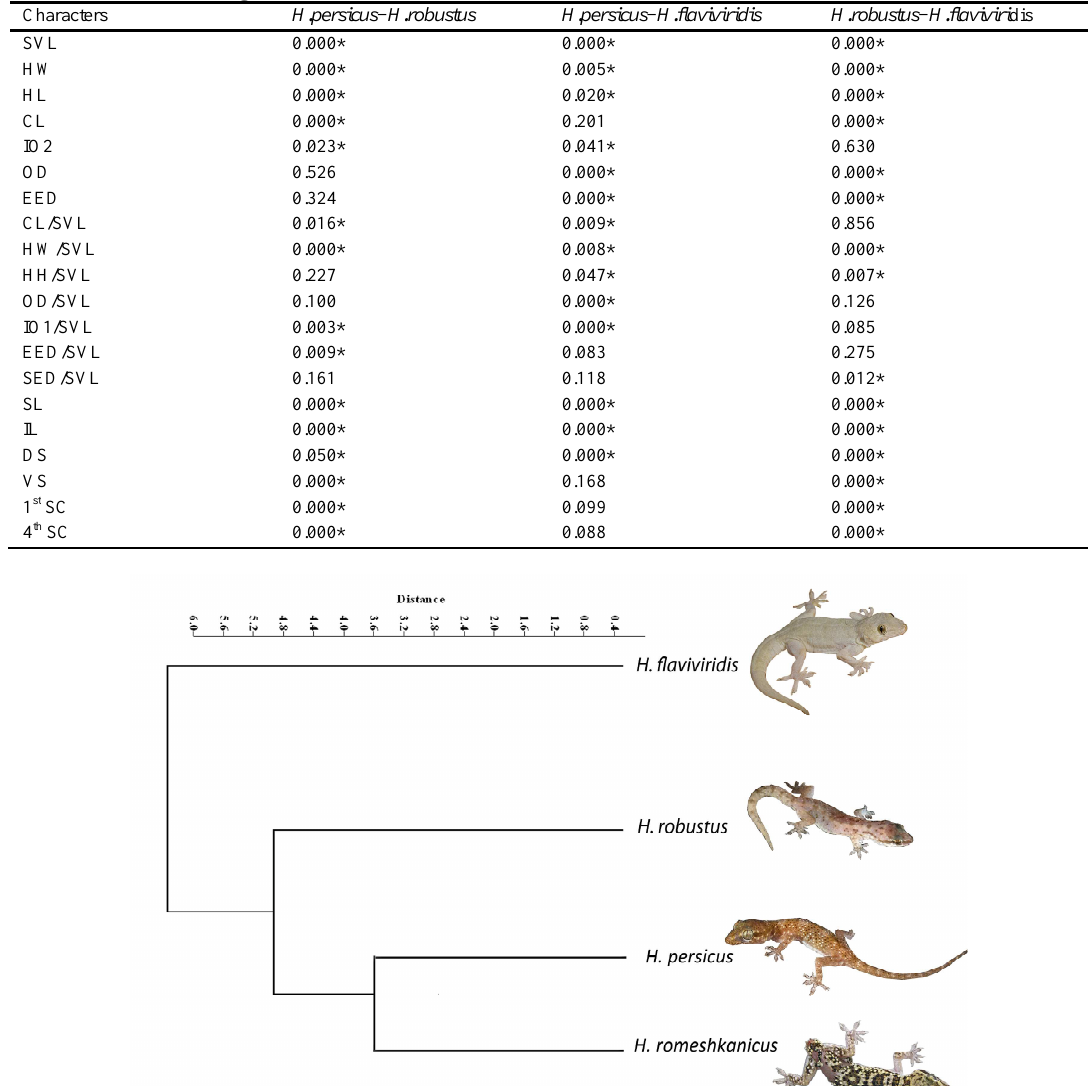
T ABLE 4. Results of pairwise ANOVA comparisons between three Hemidactylus species from Iran. Asterisks mark show significance difference (P < 0.05).